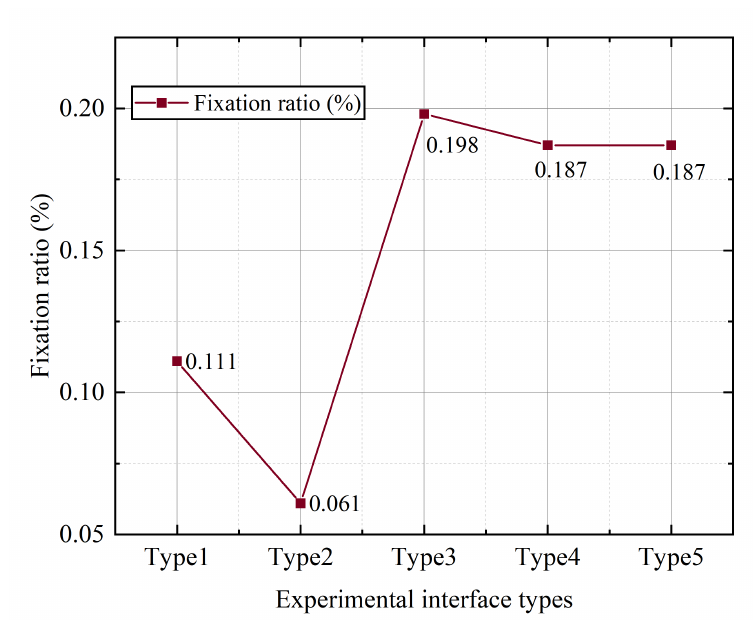
Figure 11. The average value of the fixation point ratio of buttons of different sizes.